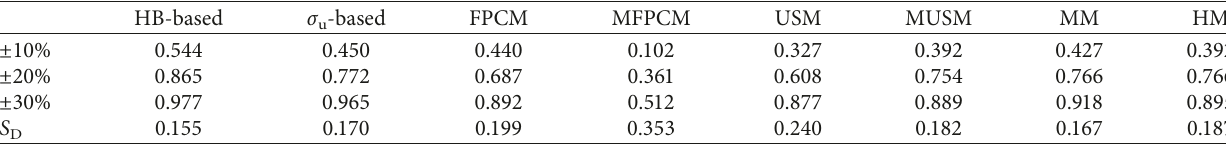
Figure 4: Comparison of the indirect methods using the tested data from [6–8]: (a) FPCM-based method, (b) MFPCM-based method, (c) USM-based method, (d) MUSM-based method, (e) MM-based method, and (f) HM-based method. Table 5: Comparison of estimation methods in terms of evaluation